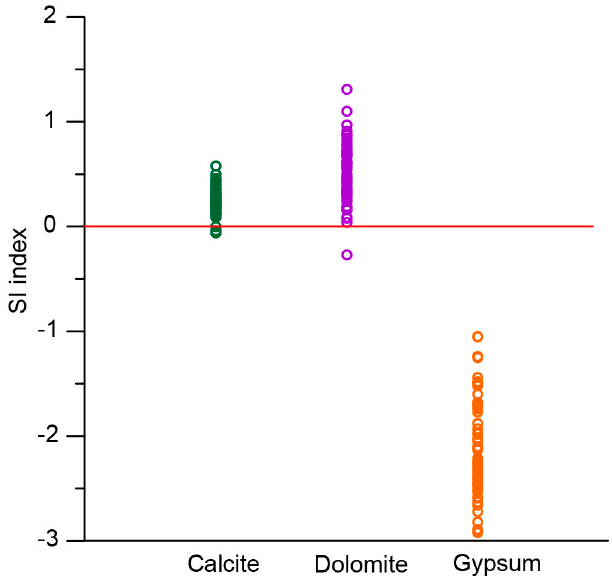
Figure 7. Saturation indices for calcite, dolomite, and gypsum.